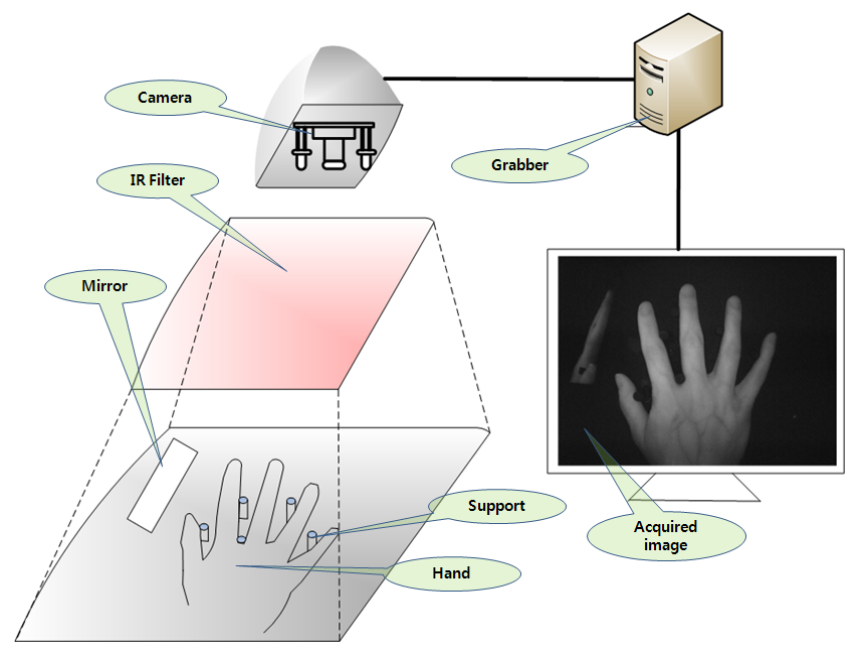
Figure 2. Acquisition of a sample image of the back of a